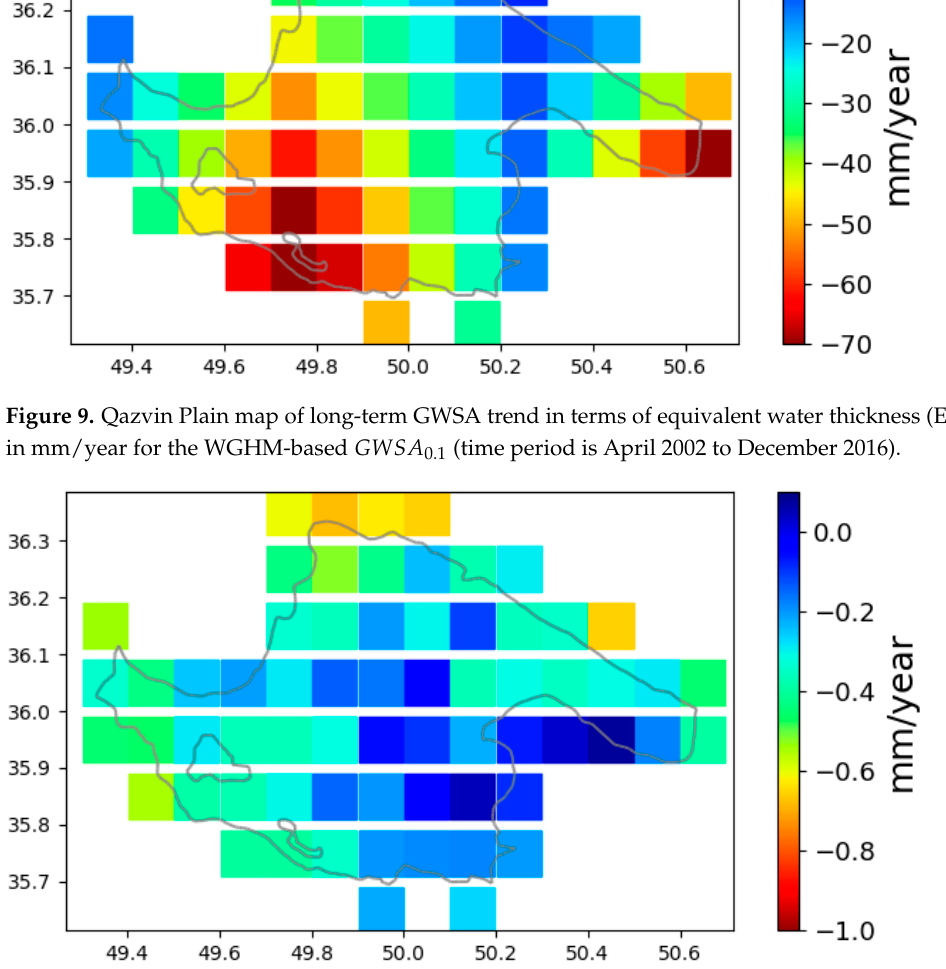
Figure 10. Qazvin Plain map of long-term precipitation trend in mm/year for Pre 0.1 anomaly (time period is April 2002 to December 2016).